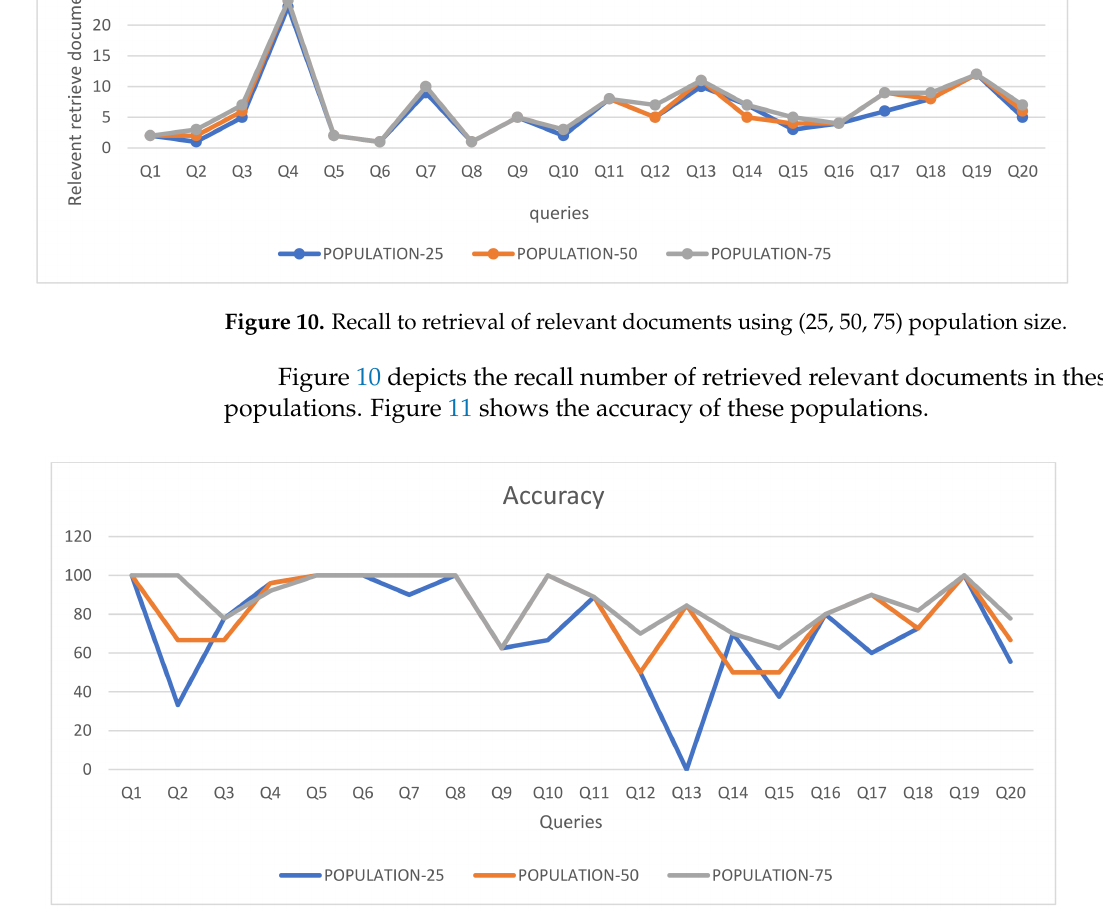
Figure 11. Accuracy of population size (25, 50, and 75).